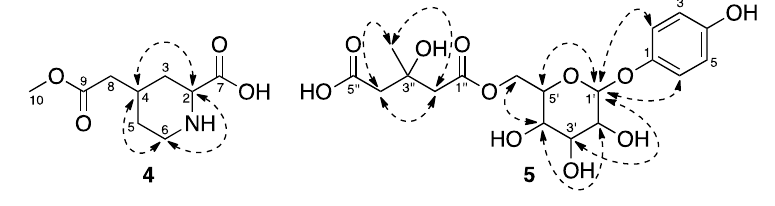
Figure 3. Key NOESY correlations of 4 and 5 .